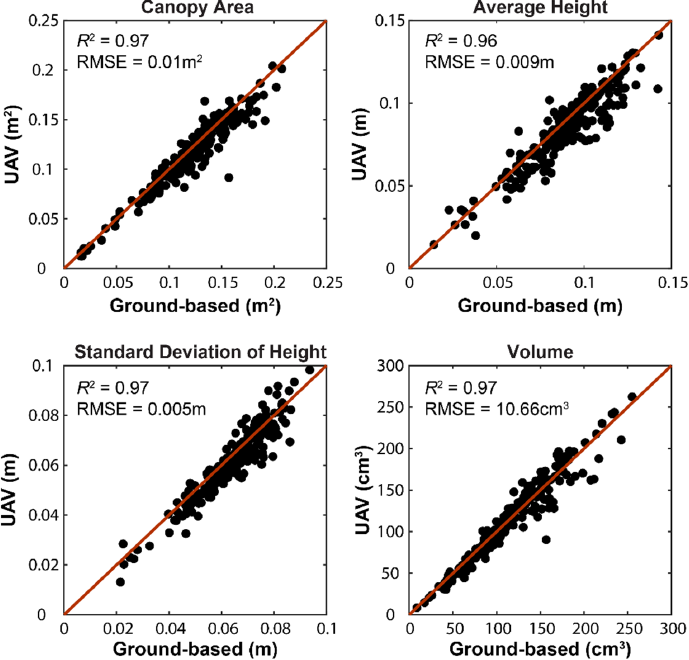
Figure 6. Scatterplots showing ground-based and UAV image-derived strawberry canopy structural parameters, including the canopy area, average height, standard deviation of height and